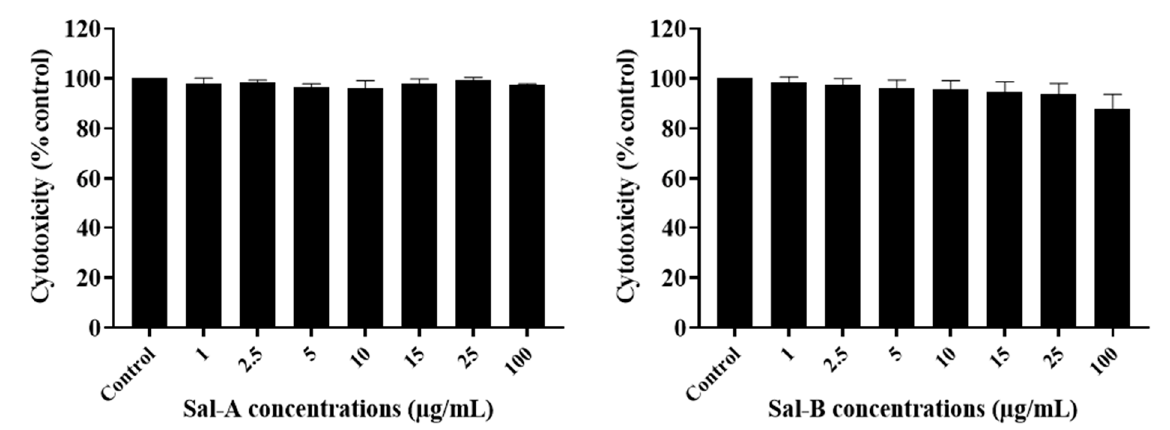
Figure 6. Cytotoxic effect of Sal- A and Sal- B on HCT116 cells. Cells were treated with 1% DMSO (control) or the indicated concentrations of the compounds for 6 h. The cytotoxic activity was determined in triplicate wells by the lactate dehydrogenase assay. Results are expressed as percentage of control and represent the average of three independent experiments ± SEM.